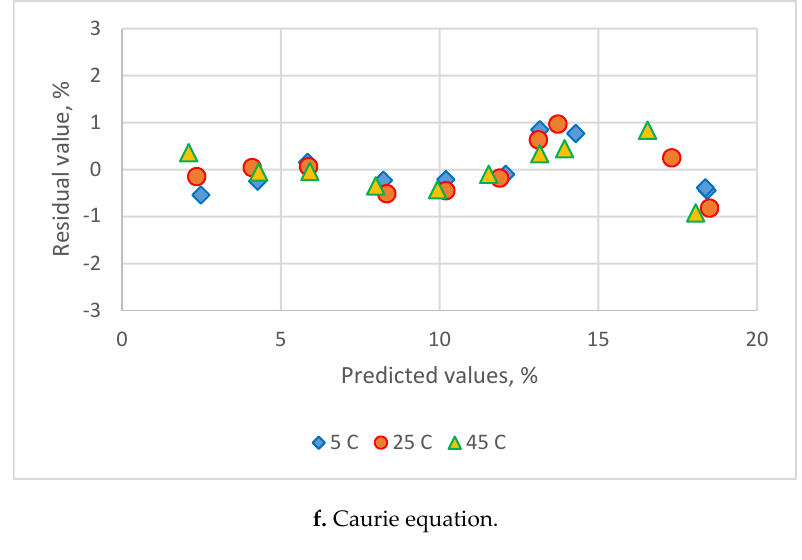
f. Caurie equation.